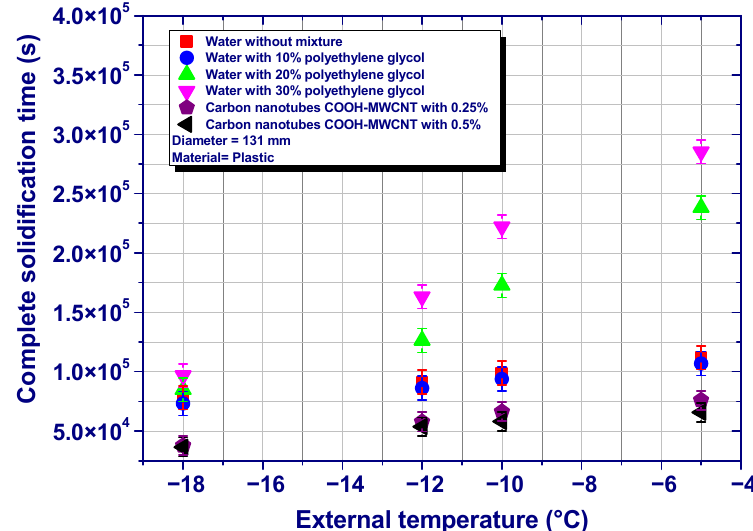
Figure 14. Impact of PCM on the complete solidification time.